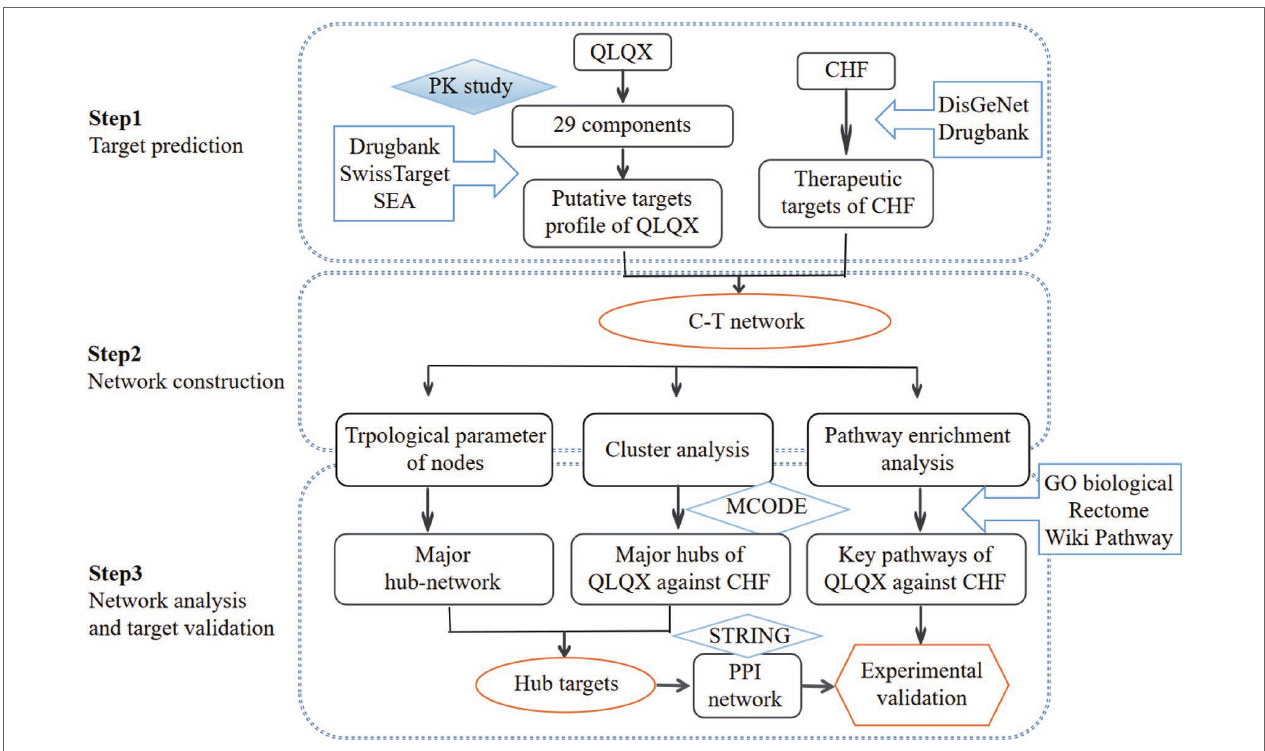
FIGURE 1 | Flowchart of the